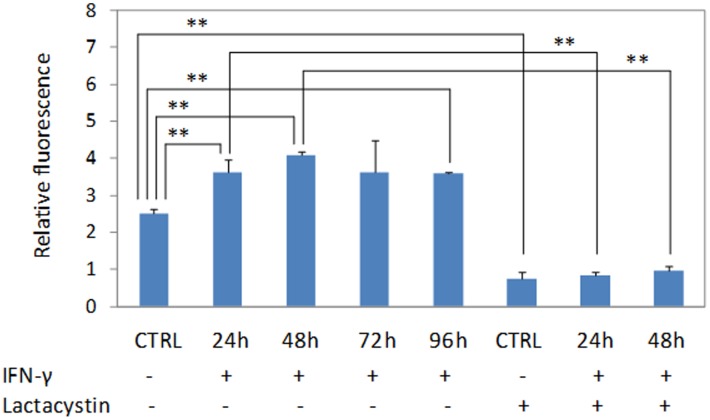
IFN-γ exposure increases immunoproteasome activities in HSG cells.The cells were treated with IFN-γ (250 U/ml) for 24–96 hrs, lysed with triton X-100, and then subjected to proteasome activity assay using fluorogenic substrate, Suc-LLVY-AMC. At each experimental condition, three cell lysates samples obtained from three separate T25 flasks (n = 3) were analyzed. **, p<0.01.